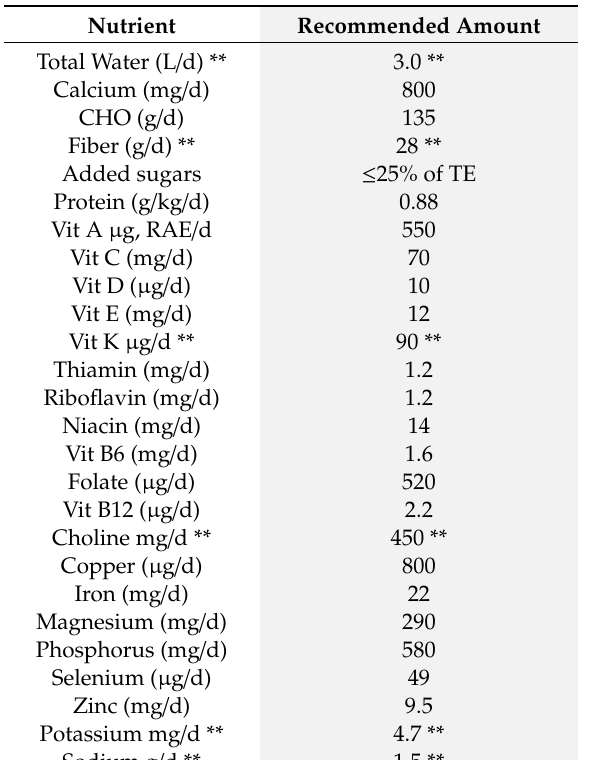
Table 1. Estimated average requirements (EAR) 1 for